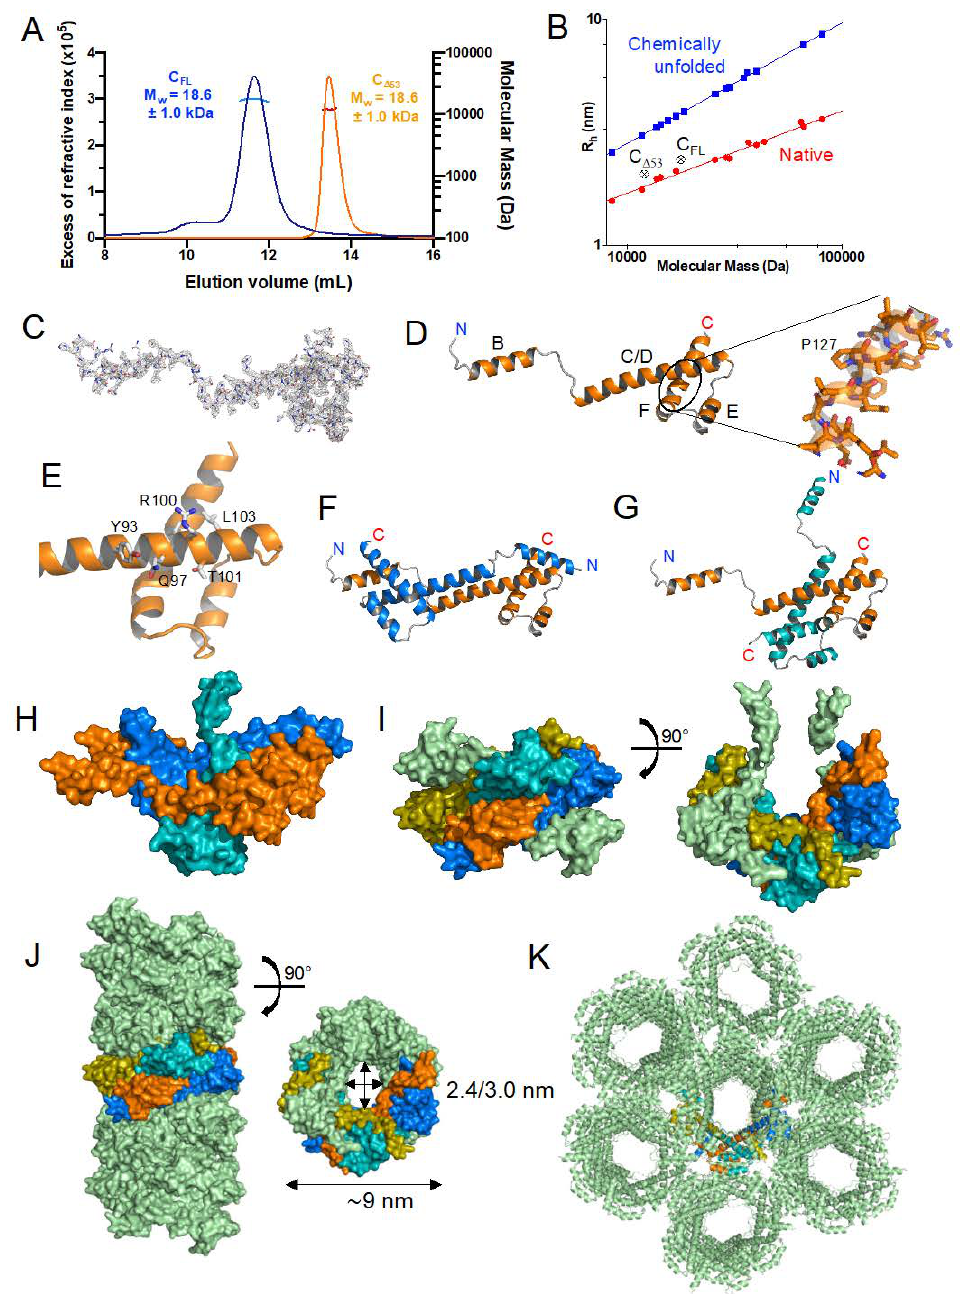
Figure 3. Crystal structure of TupV C protein C-terminal domain (C ∆ 53 ). ( A ) SEC-MALLS of TupV C ∆ 53 and C FL . The lines show the chromatograms monitored by differential refractive index measurements. The crosses indicate the molecular mass across each elution peak calculated from static light scattering and refractive index, and the numbers indicate the weight-averaged molecular mass (kDa) with standard deviations (the molecular mass calculated from the aa sequence are 17,807 Da for C FL and 11,897 Da for C ∆ 53 , respectively). ( B ) Plot of the hydrodynamic radius measured by SEC as a function of the molecular mass measured by MALLS and RI. The blue and red circles show data taken from [42] for globular proteins in native or chemically unfolded forms, respectively. ( C ) Electron density map of one protomer in the asymmetric unit contoured at 1.8 s and stick representation of the TupV C ∆ 53 protein in the crystal structure (PDB ID: 8BJW). ( D ) Cartoon representation of